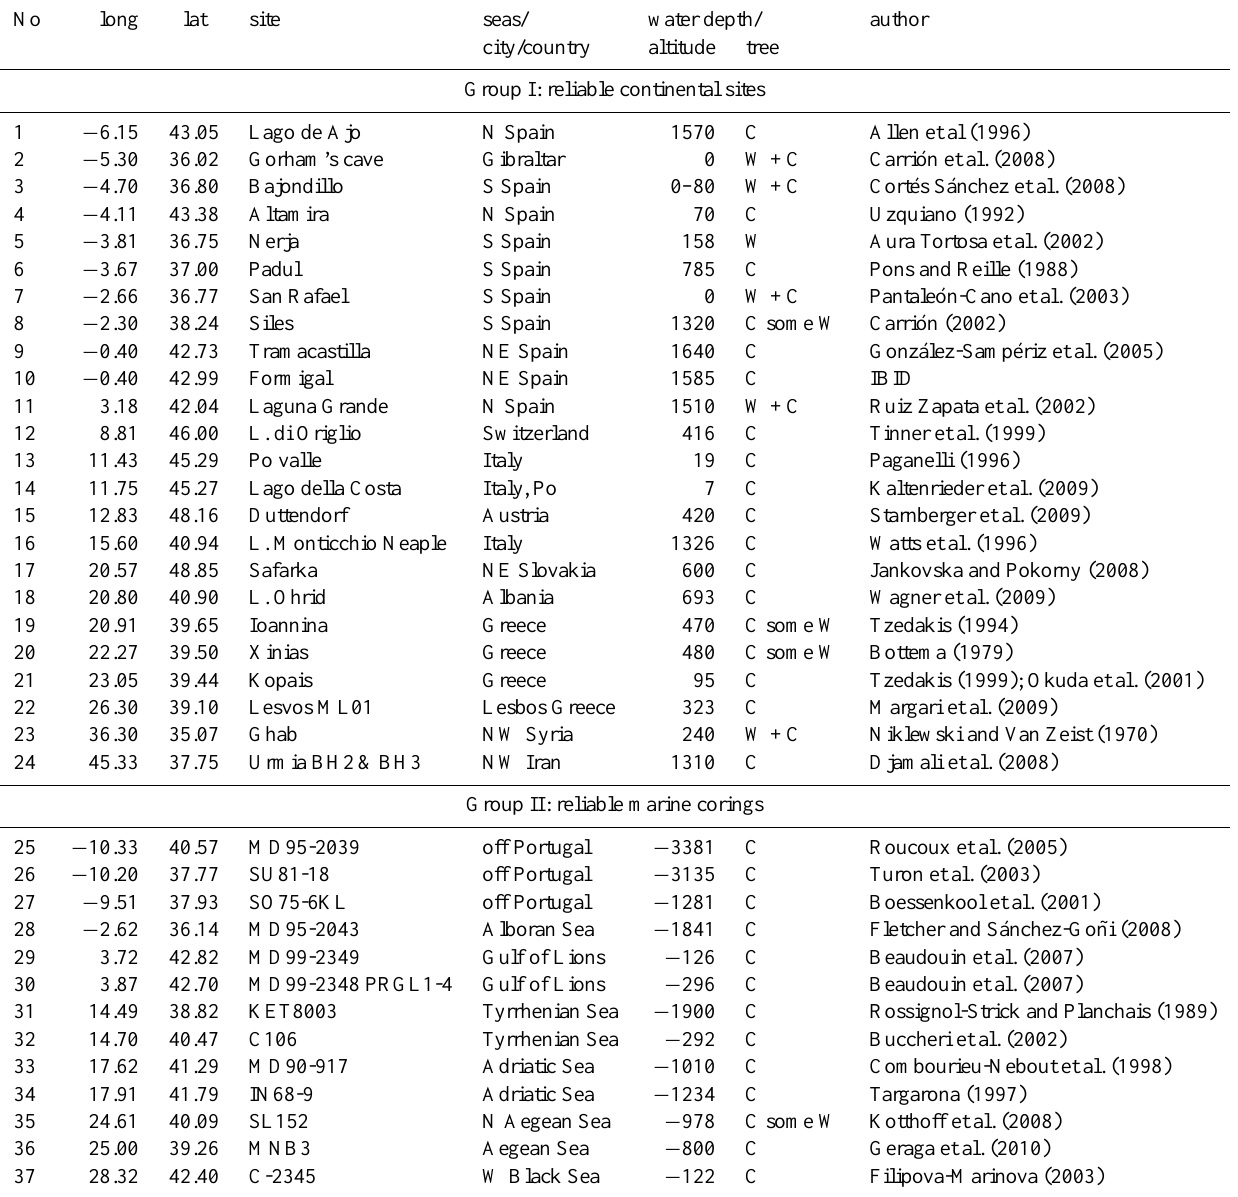
Table 4. Reliable continental and marine sites with summer-green tree growth during the LGM from west to east. In column “tree” the letters W mean warm-loving trees and C cold-tolerant trees. The evidence of tree growth comes mostly from pollen analysis, except sites 4 (Altamira) and 5 (Nerja) which have findings of charcoal, and site 2 (Gibraltar) which has evidence from pollen and fossil